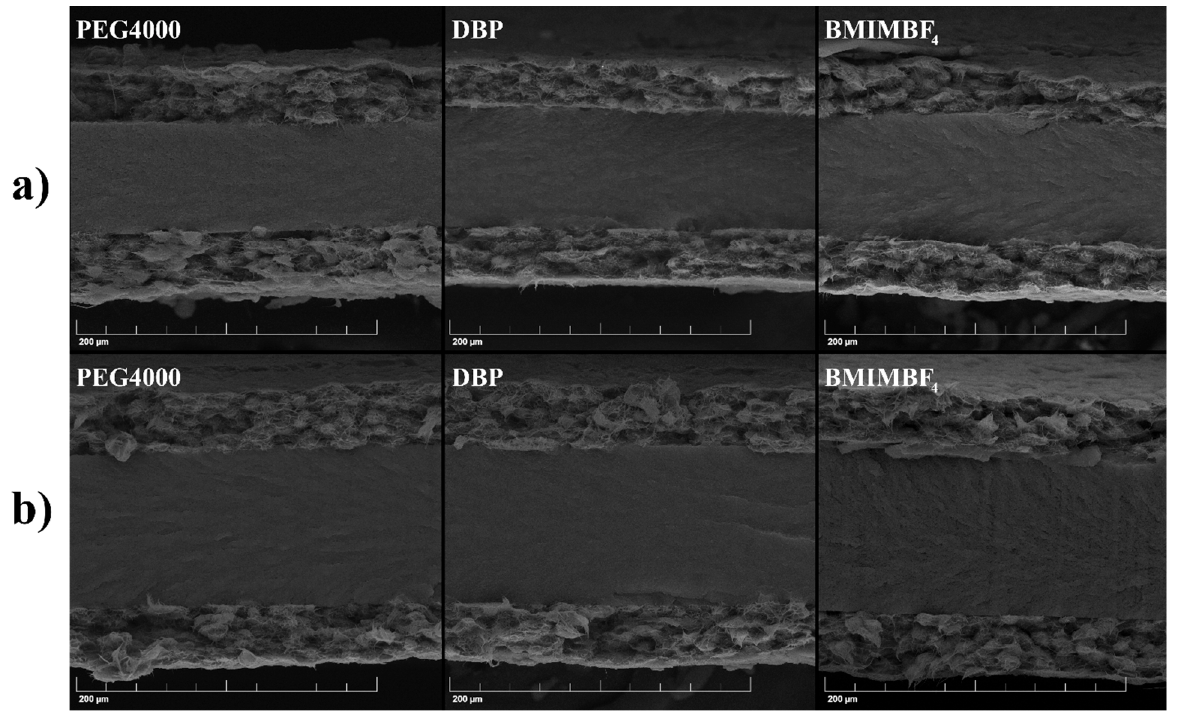
Figure 5. Microphotographs of cross-sections of actuators with: ( a ) BMIm membrane and ( b ) OMIm membrane.